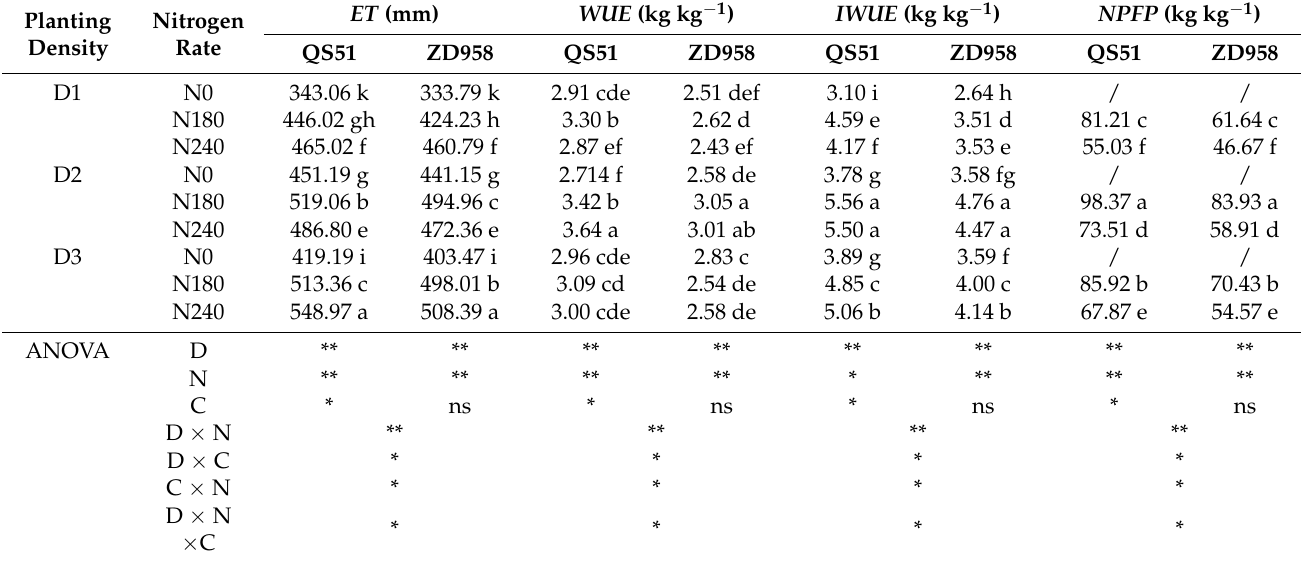
Table 4. Effects of different planting densities and nitrogen rates on water-fertilizer use efficiency of the two maize